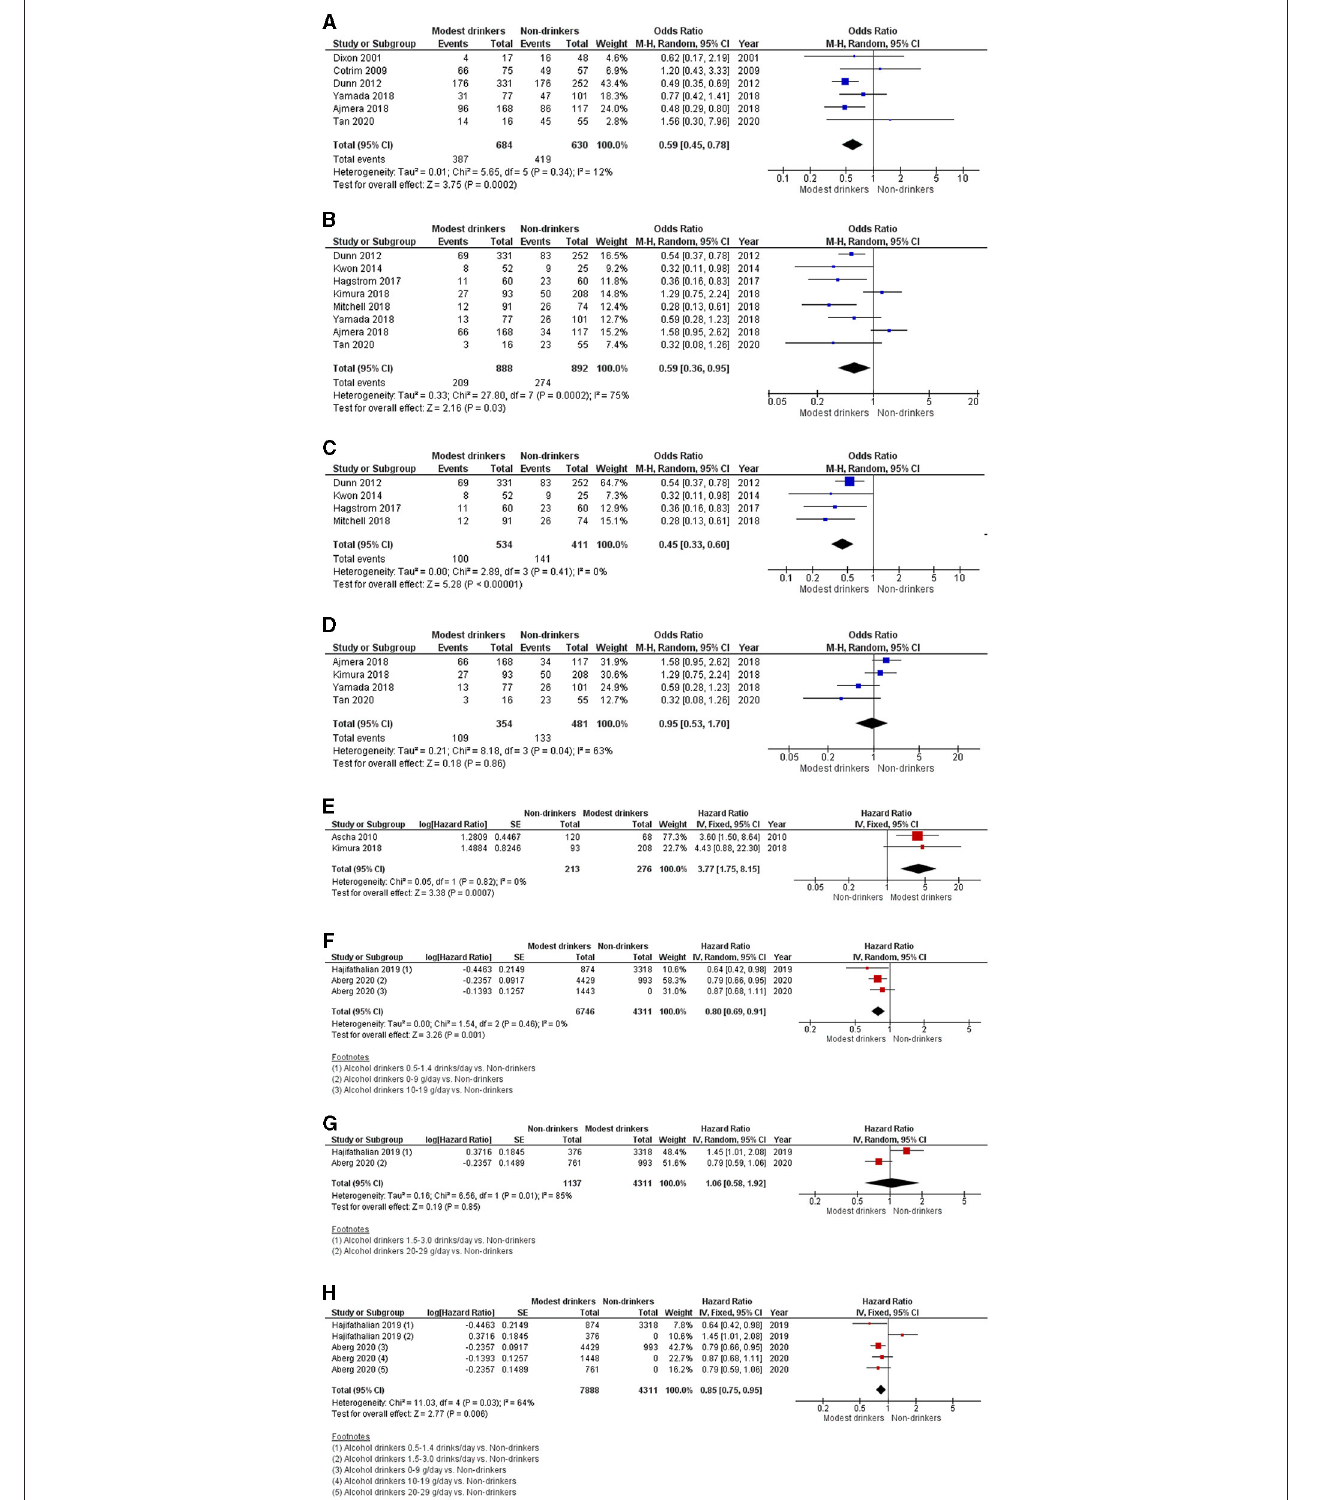
FIGURE 2 | Forest plot of meta-analyses for the association between modest alcohol consumption in NAFLD patients and (A) steatohepatitis; (B) advanced fibrosis; (C) advanced fibrosis among high-quality studies; (D) advanced fibrosis among low-quality studies; (E) the development of HCC; (F) mortality for light alcohol consumption; (G) mortality for moderate alcohol consumption; and (H) light-to-moderate alcohol consumption.